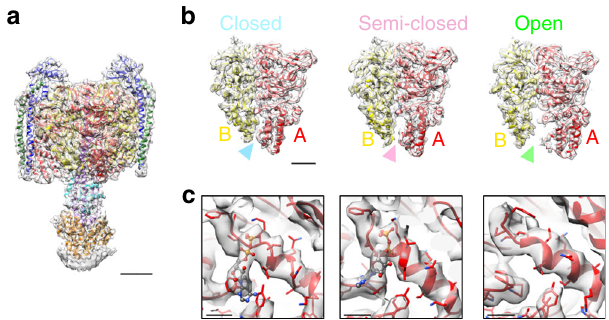
Fig. 2 Structural comparison of the three AB pairs in state1. a The EM map in state1 with focus on the V 1 EGd (A 3 B 3 DF(EG CT ) 2 d) subdomain. The density of the membrane embedded region was subtracted by focused re fi nement using the mask of V 1 EGd. The map is shown in semi-transparent gray. Scale bar, = 30 Å. b Side views of the three AB pairs, “ closed ” , “ semi- closed ” , and “ open ” corresponding to those of the cross-section shown in Fig. 1c. Scale bar, = 20 Å. c Magni fi ed views of the nucleotide-binding site at each AB pair. ADP is depicted in ball and sticks format. Experimental maps are shown in semi-transparent gray. Scale bar, = 5